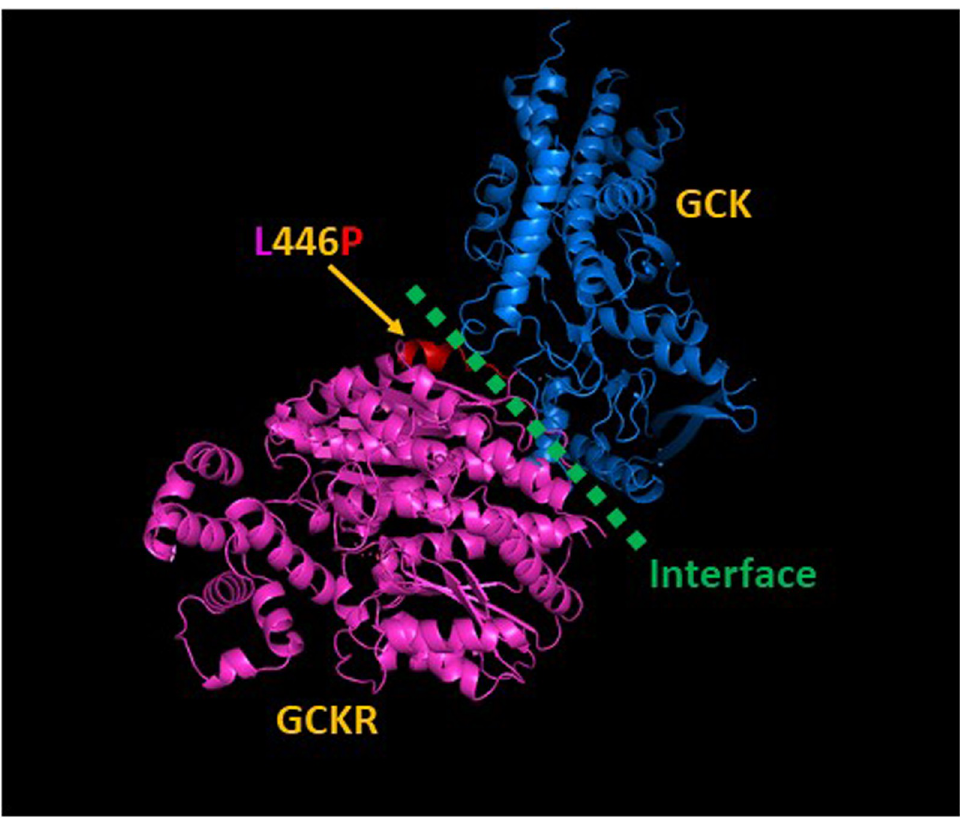
Fig 2. Wild type GCKR protein (pink) interacts with wild type GCK protein (blue). The position of interaction in GCKR is L446 (rs1260326, red). Green dotted line presents the proximity of the interface between GCK and